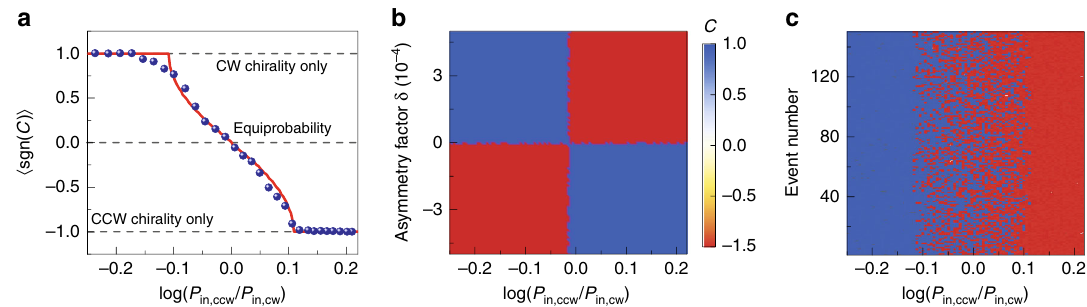
Fig. 5 Switch of the chiral microlaser. a Sign of chirality averaged over different scans ( h sgn ðCÞi ) is tuned by the bias in the pump intensities, as quanti fi ed = P Þ . The experimental (theoretical) results are shown by the blue dots (red curve). b Dependence of the Raman laser chirality on the here by log ð P in ; cw in ; ccw bi-directional pump ratios and the asymmetry gain factor δ . Here the phase difference between the two-sided inputs is set to be π . c Theoretical prediction for the emergence of laser chirality with the same total pump power and different bi-directional pump ratios. For every pump ratio, 150 chiral lasing events are calculated with random phase differences between the bi-directional inputs. Averaging over these random phases results in the red curve in